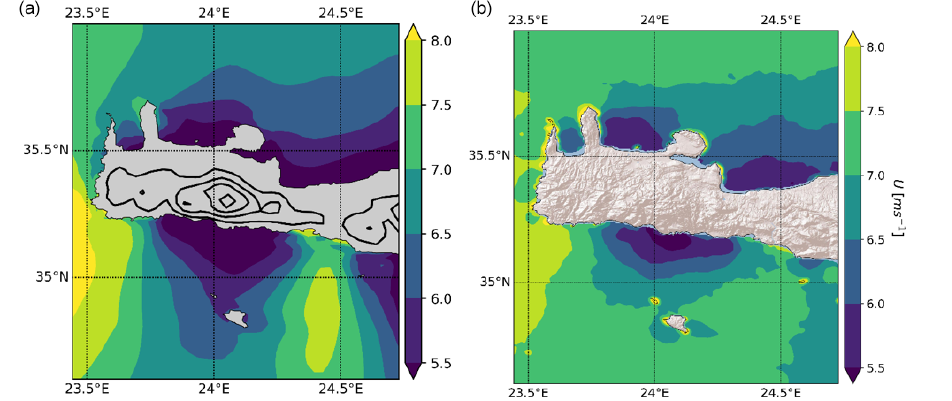
Figure 7. Mean wind speed (ms − 1 ; 2002–2018) at 10ma.m.s.l. for (a) WRF and (b) SAR. All 549 coinciding scenes are used in both datasets.